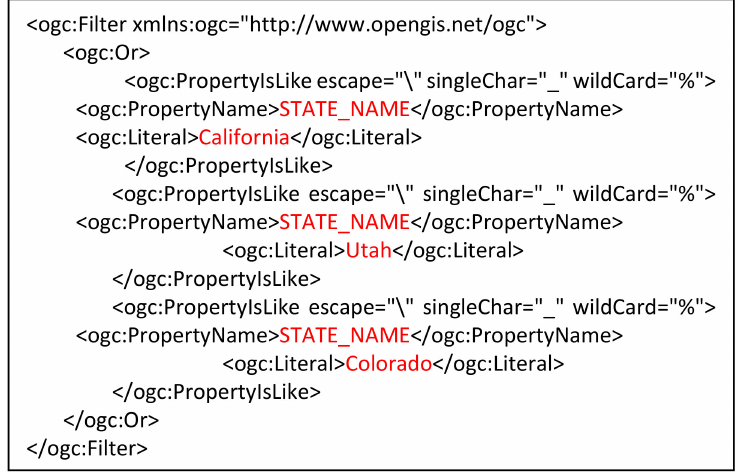
Figure 11. An example of spatial filter for three states in the